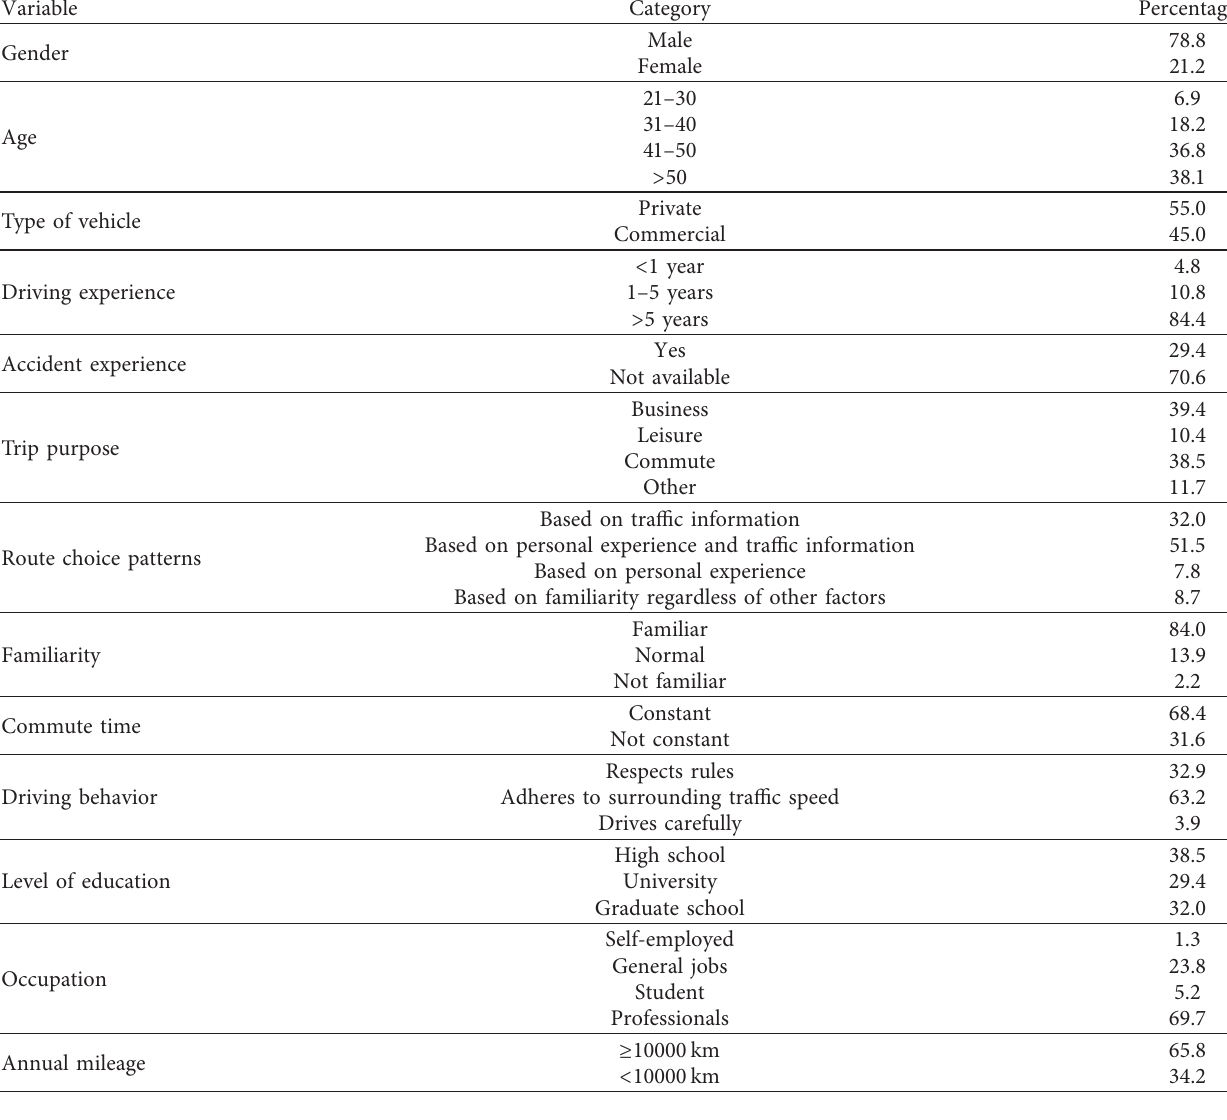
Table 1: Socioeconomic and travel characteristics of survey